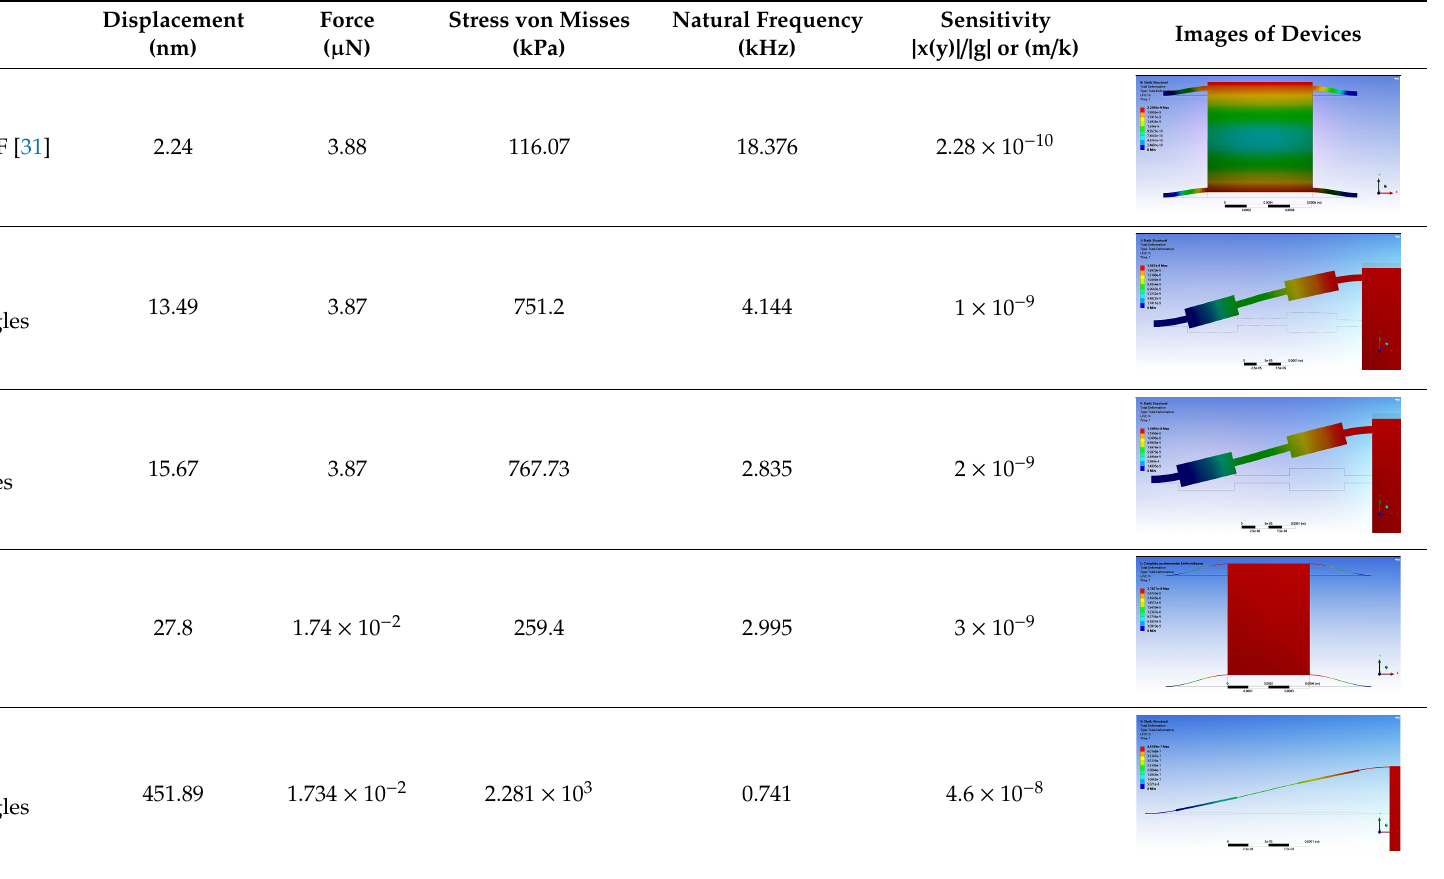
Table 12. Comparison of performance parameters with other authors.